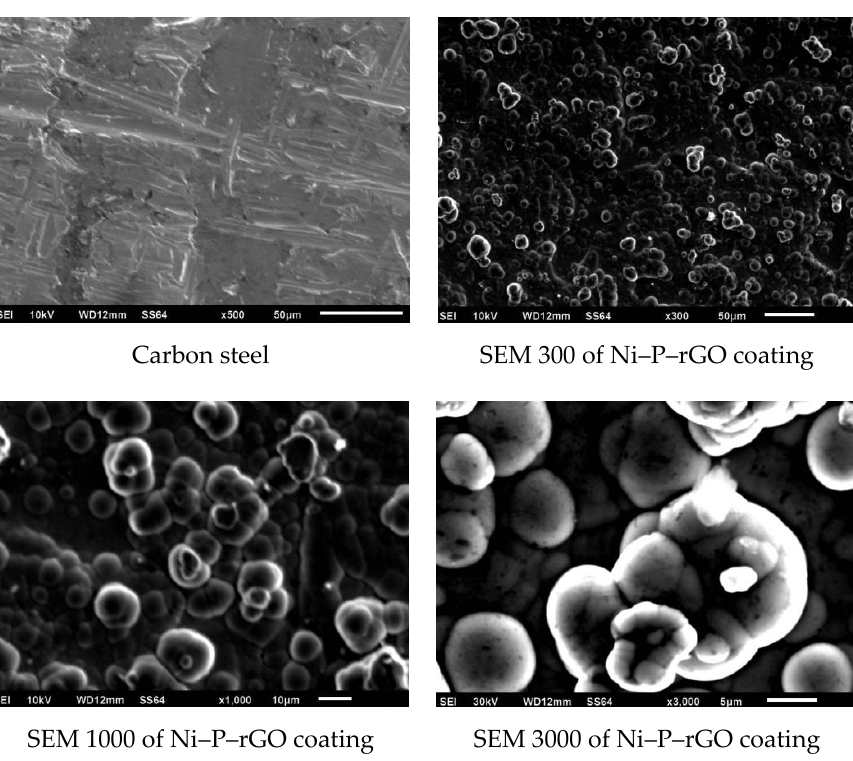
Figure 1. SEM morphology of the carbon steel and the nickel–phosphorus–reduced graphene oxide (Ni–P–rGO) coating.